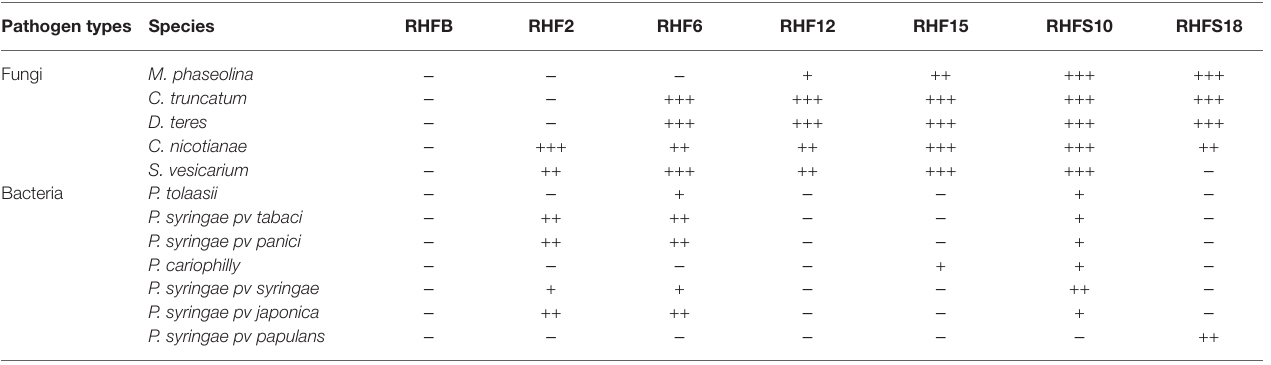
TABLE 6 | Antimicrobial activity of the seven selected strains against phytopathogenic fungi and bacteria. Pathogen types